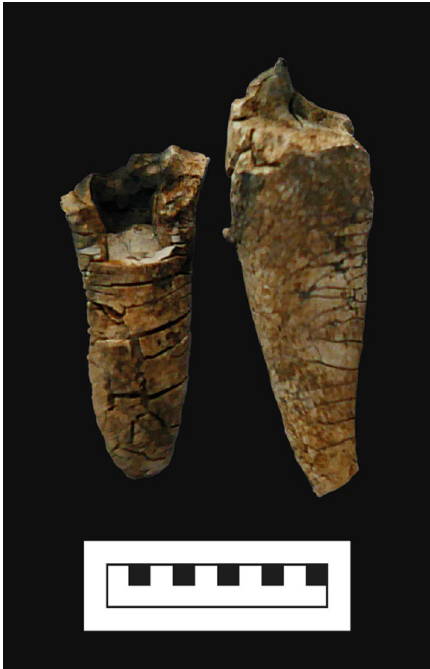
Figure 5. Burnt dental roots from an Early Medieval cremation deposit from Broechem, Belgium, showing a variation in burning